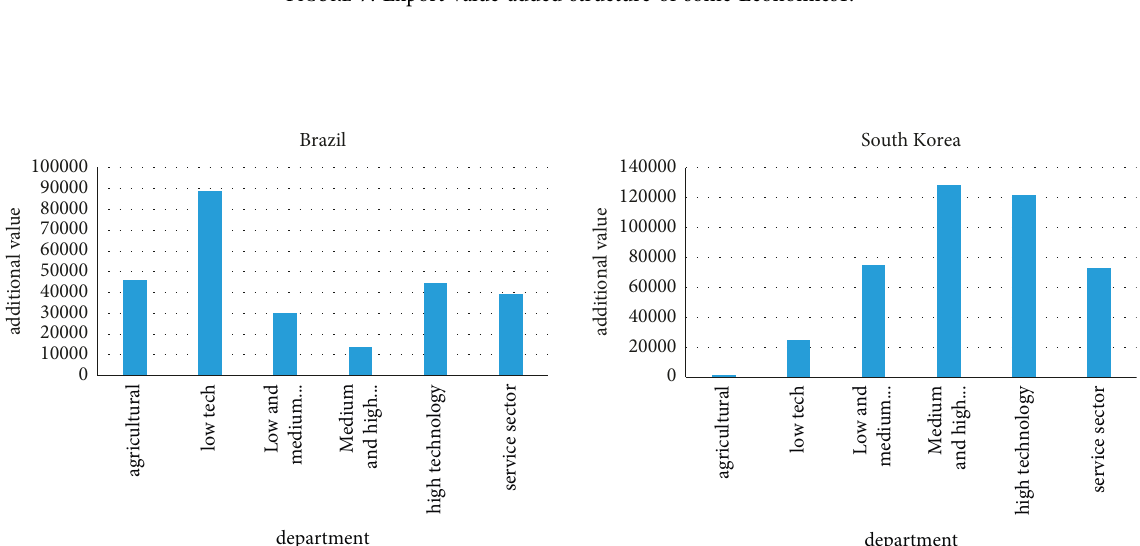
Figure 8: Export value-added structure of some Economies2.